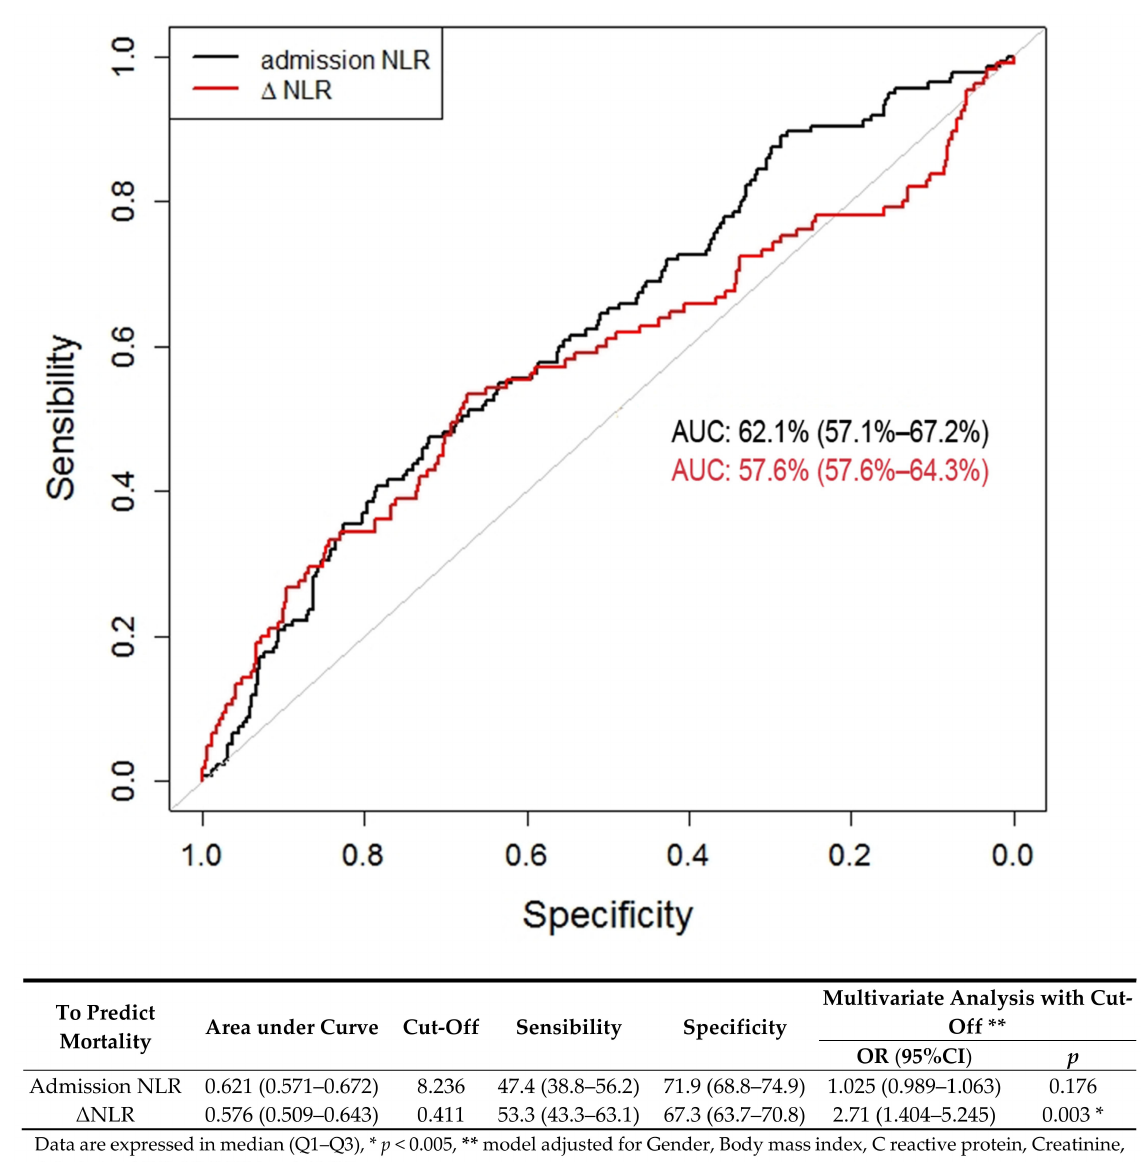
Figure 3. Receiver operating characteristics (ROC) curve for NLR as a predictive factor of mortality in COVID-19